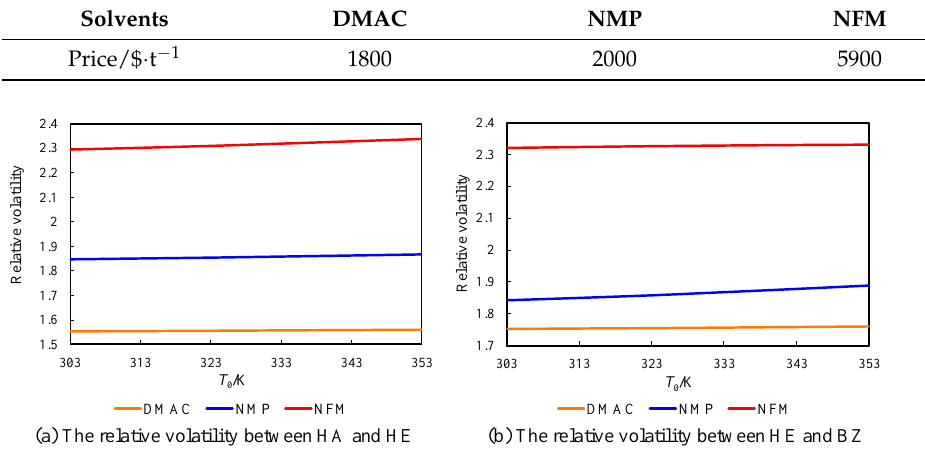
volatility (α) versus reactor inlet temper ature ( T 0 ) curve is calculated for every pair of ad- jacent components and plotted in Figure 7. As the inlet temperature of reactor increases, the relative volatilities between components increase accordingly. When NFM is em- ployed, the relative volatilities are much greater than those when the other two solvents are used. When the solvent DMAC is employed, components have the minimum relative volatility. Table 2. Prices of the three candidate solvents. Table 2. Prices of the three candidate solvents. Table 2. Prices of the three candidate solvents. Solvents